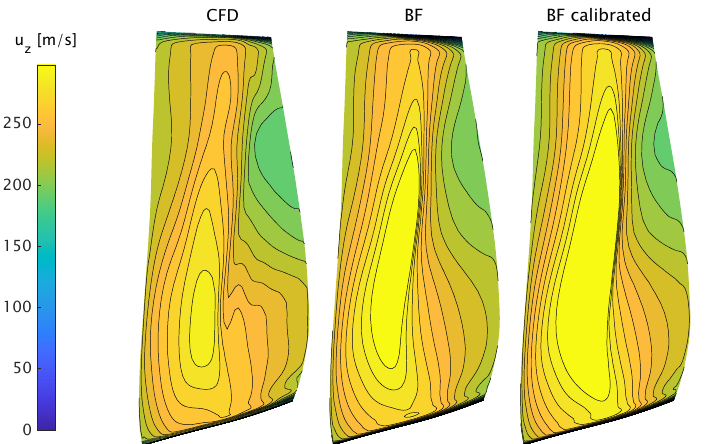
Figure 12. Axial velocity contours at near-choke for reference CFD solution, baseline, and cali- brated